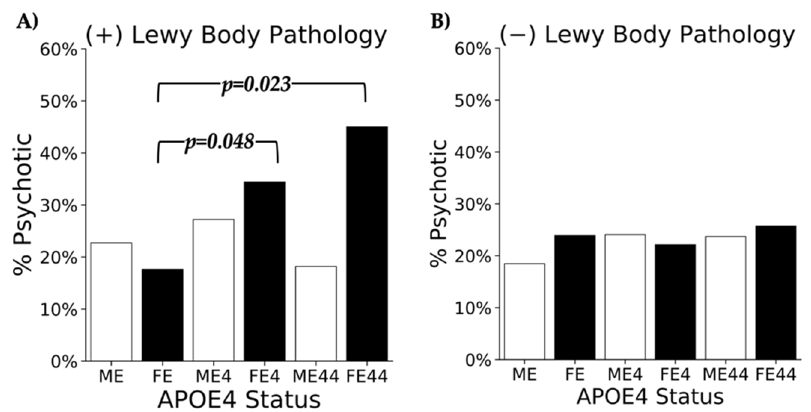
Figure 3. % Psychotic Across Cohorts.